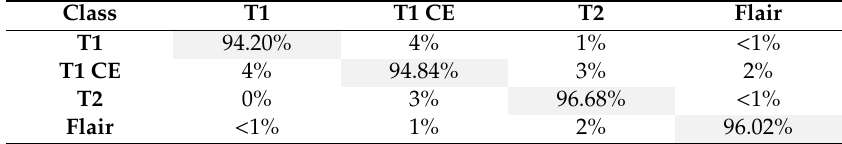
Table 6. Confusion matrix of ELM using the Pro-FC7 approach for the BraTS 2017 dataset.